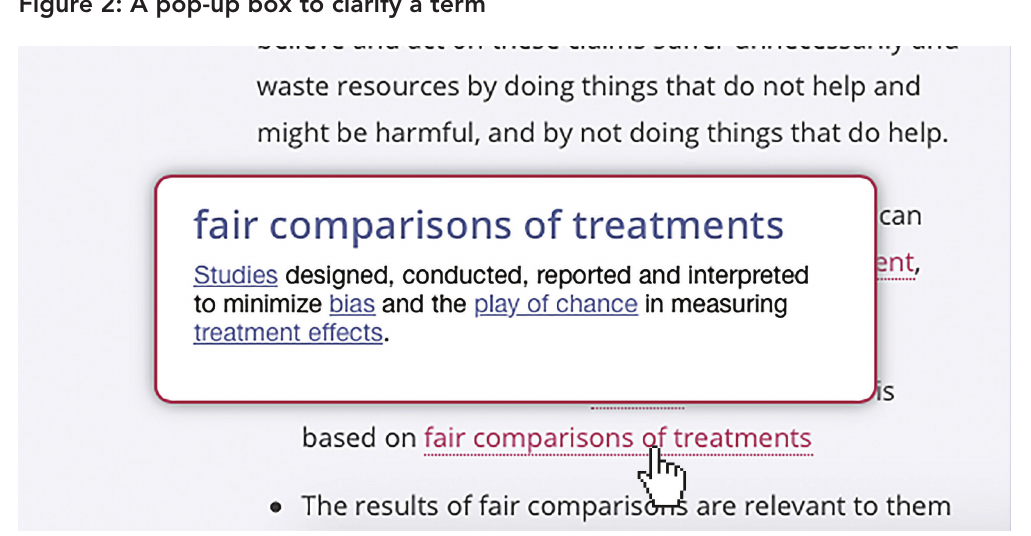
Figure 2: A pop-up box to clarify a term